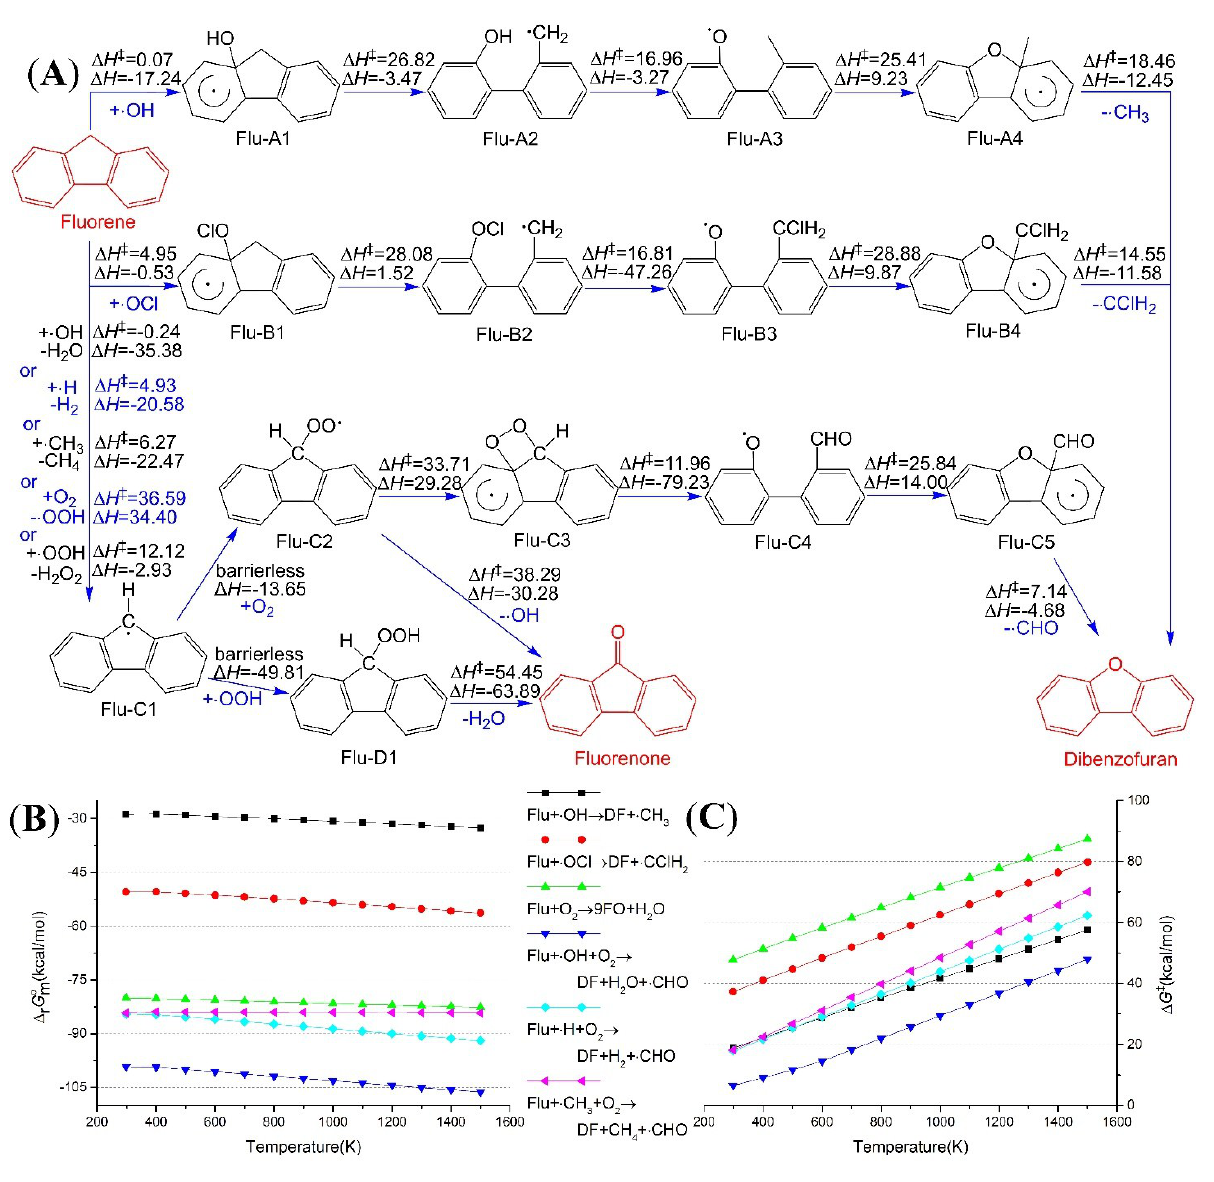
Figure 2. Dibenzofuran and 9-fluorenone formation paths from fluorene (Flu); ( A ) Reaction scheme, enthalpies were calculated at 1000 K, and energy unit is kcal/mol; ( B ) Standard Gibbs energy changes for the overall reactions; ( C ) Activation Gibbs energies for the overall